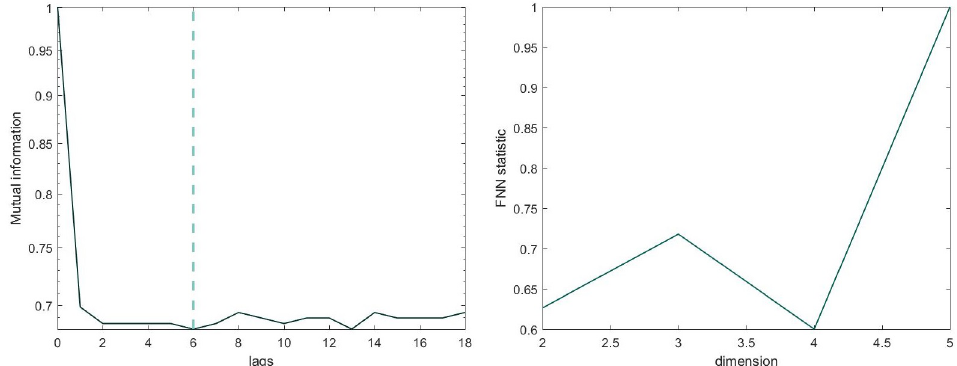
Figure 1. Optimal value of the parameters for an exemplary window. Left: optimal delay τ calculated with auto-mutual information. The dashed line determines the first local minimum ( τ = 6 ) . Right: the minimum embedding m employing the False Nearest Neighbourhood (FNN) method. At m = 4, the FNN statistic is